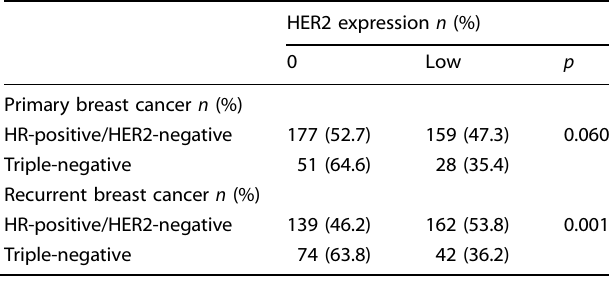
Table 2. HER2 expression distribution according to breast cancer subtype in the HER2-negative primary and recurrent breast cancer cohort.